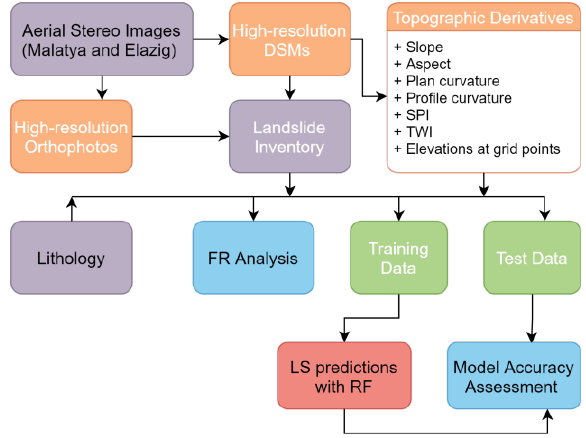
Figure 1. The input datasets and the methodological workflow of the study.